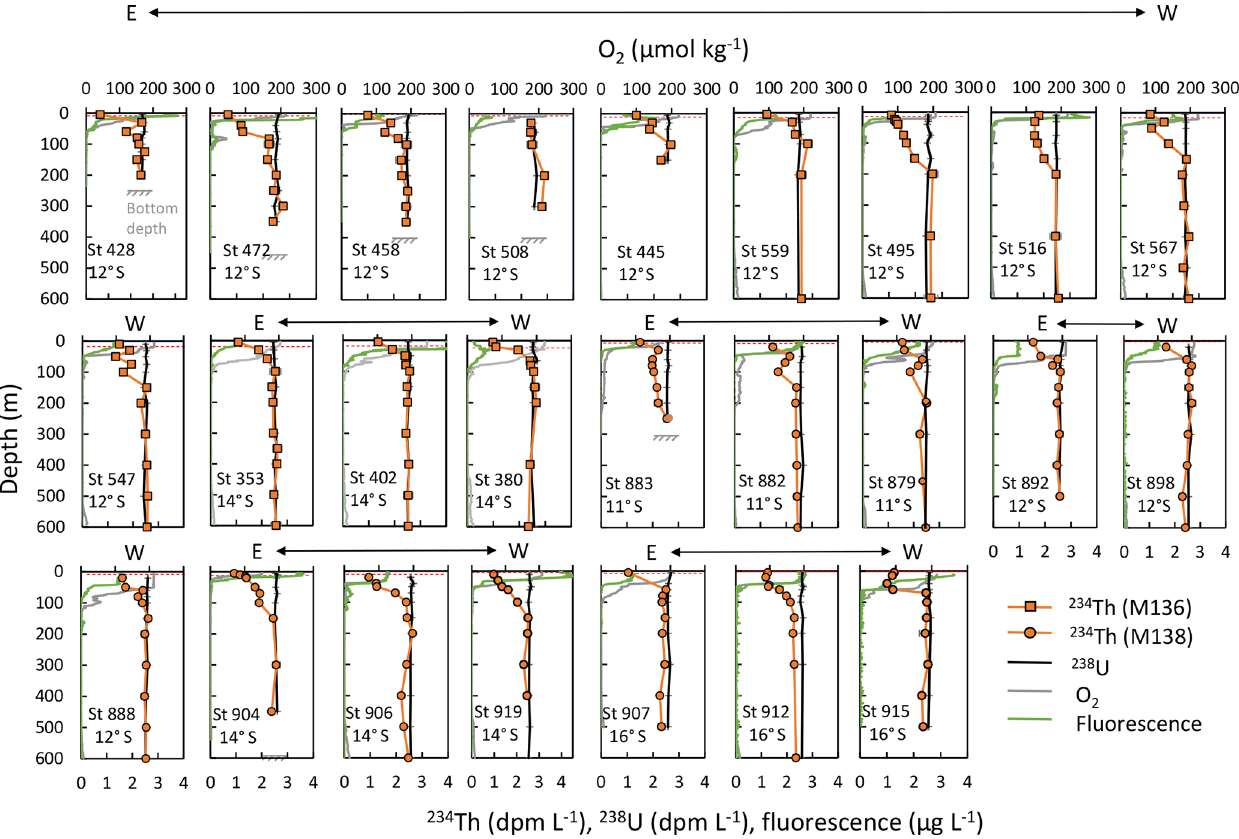
Figure 2. Profiles of 238 U (black) and 234 Th (orange squares – M136; orange circles – M138) along with concentrations of oxygen (grey) and fluorescence (green). Profiles are organized by cruises, transects, and distance to shore from left to right and top to bottom, indicated by east (E) to west (W) arrows. Error bars for both 238 U and 234 Th are indicated. Dashed red lines indicate the depth of the mixed layer. The start of the oxygen-deficient zone is where oxygen diminishes. Bottom depths are indicated for stations whose bottom depths are shallower than